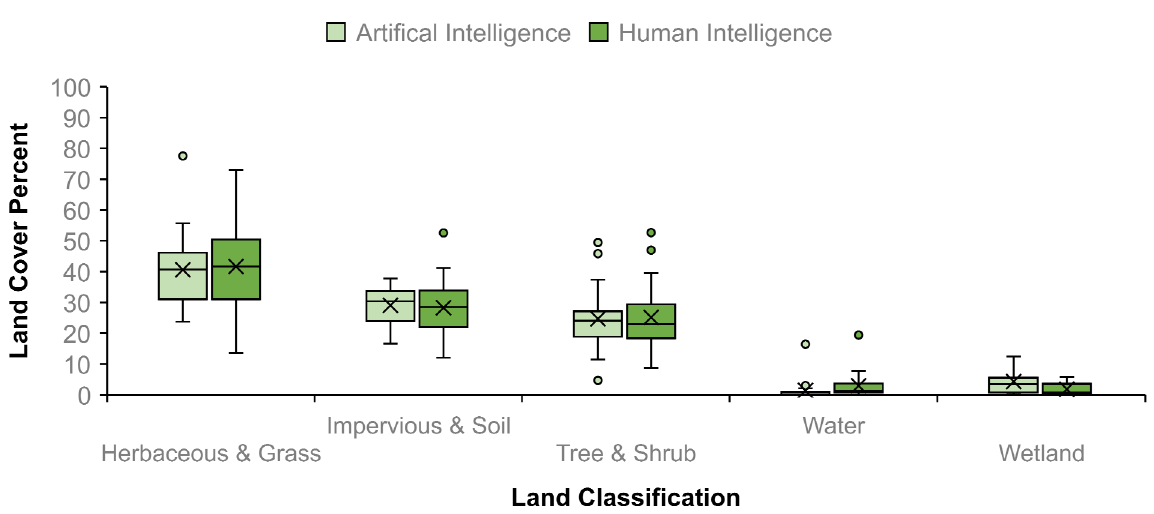
Figure 2. Landcover classification boxplot comparison between artificial intelligence and human intelligence in Dane County, WI, USA (n = 21). Only water and wetland were significantly different